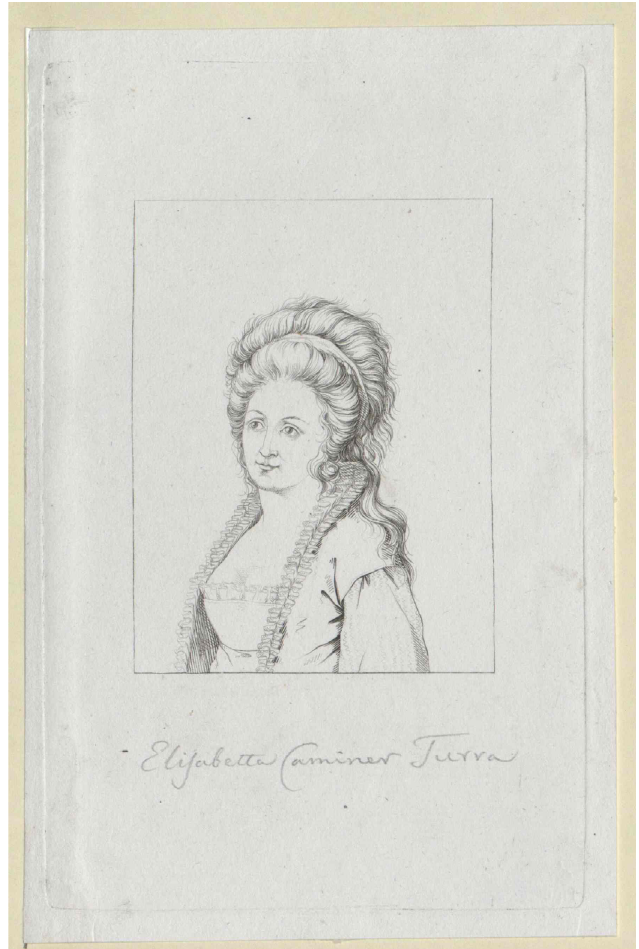
Fig. 1 Elisabetta Caminer Turra (1751–96). Europeana/Österreichische National- bibliothek Digital